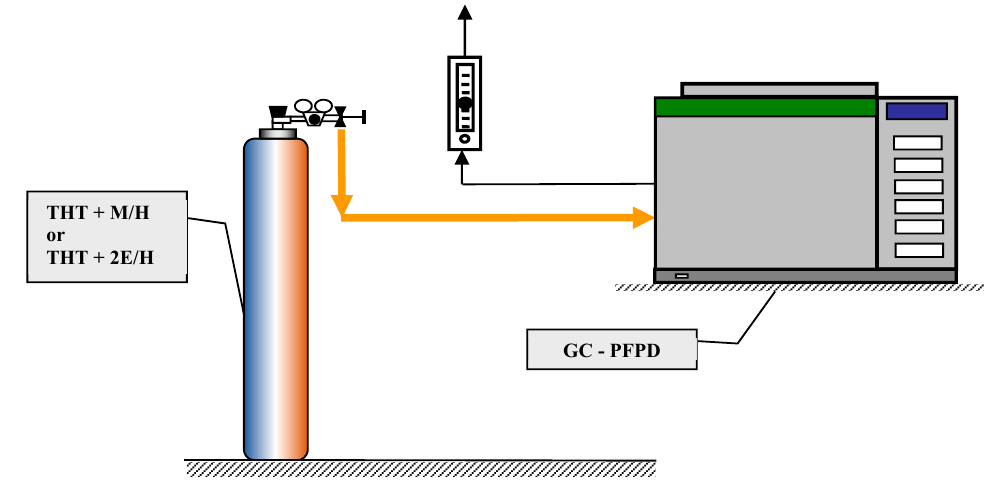
Figure 3. Block diagram of the apparatus in the station examining the composition of gaseous mixtures.